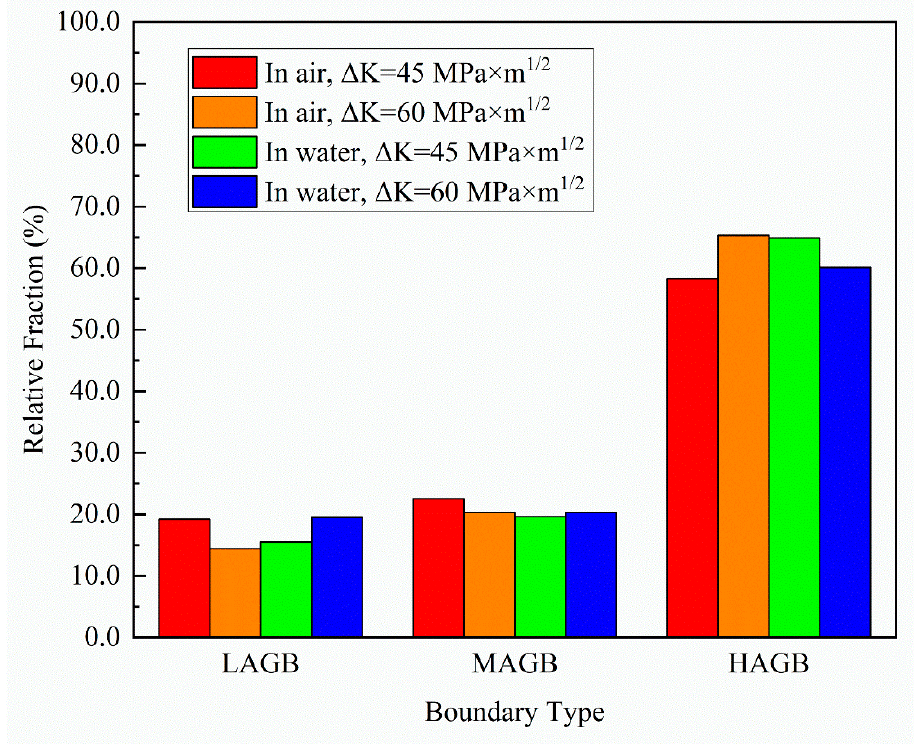
Figure 12. Grain boundary types analysis in X80 steel welded joints.